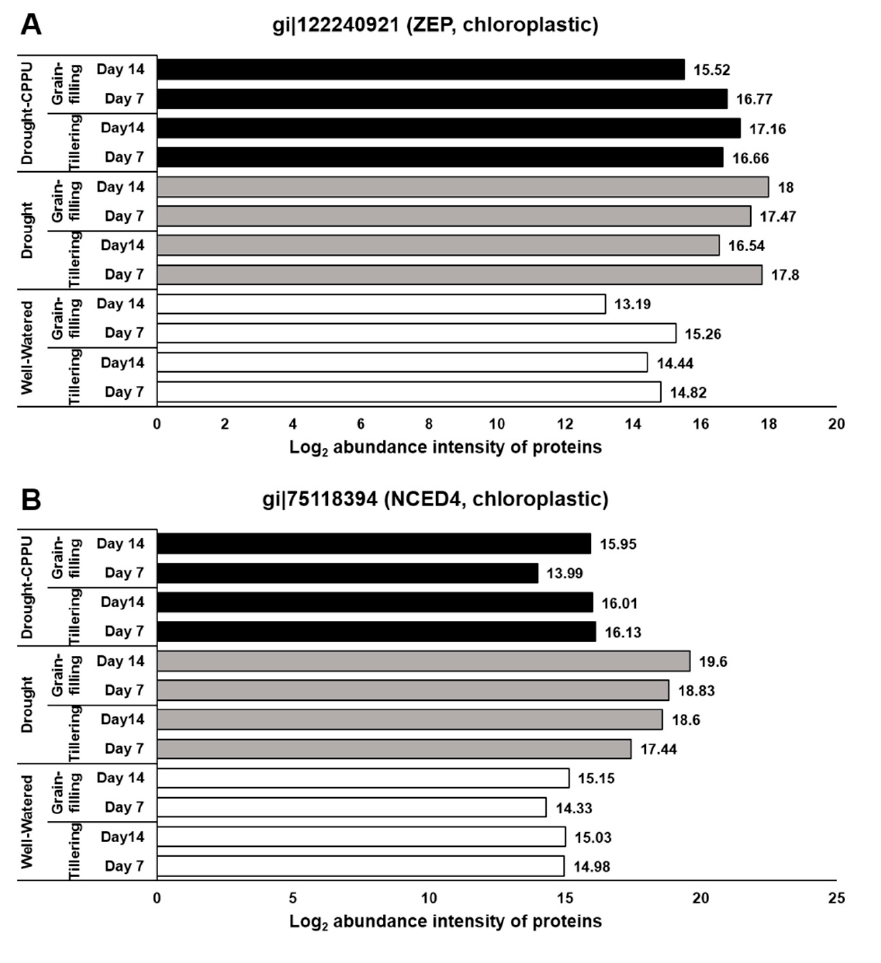
Figure 2. The influence of synthetic cytokinin and drought on the abundance intensities of ZEP ( A ) and NCED4 ( B ) proteins, implicated in ABA biosynthesis and stomatal conductance, at the tillering and grain-filling stages of the rice. Protein abundance intensities, represented on the X-axis, are the highest log2 fold change values of technical replicates. [Well-Watered plants were maintained at a soil moisture tension of − 15 kPa during the treatment period. Drought stress was imposed by withholding water for up to 14 days. Soil moisture tensions of − 55 kPa and − 72 kPa were recorded at day 7 and day 14 during the treatment, respectively. CPPU treatment was given by foliar spraying plants with a 5 mg / L solution of CPPU at the rate of 25 mL / plant on day 6 of drought treatment.